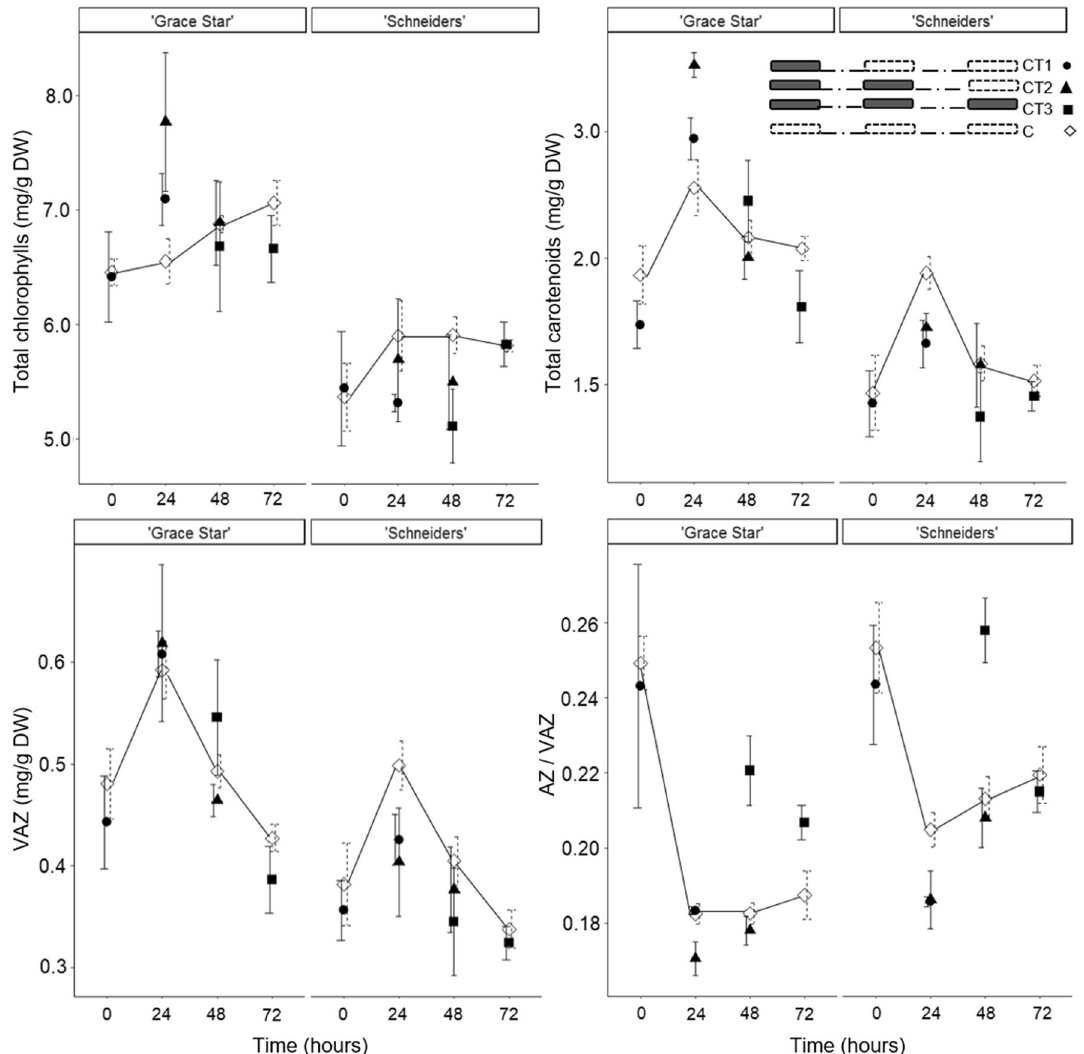
Figure 2. The total chlorophylls, total carotenoids, VAZ (xanthophyll cycle pigments) and AZ/VAZ (deepoxidation state of xanthophyll cycle pool) in leaves of ‘Grace Star’ and ‘Schneiders’, sampled at time 0, time 24, time 48 and time 72 in Experiment I. The overnight chilling treatment (CT) comprises four patterns: CT1 (one exposure, black filled circle); CT2 (two exposures, black filled triangle); CT3 (three exposures, black filled square) and C (control trees, white filled diamond). A black filled rectangle indicates the night-time exposure to CT, while white filled rectangle indicates the night under natural conditions. Vertical bars represent ± SE of the mean (n = 3; n = 3 and 6 for